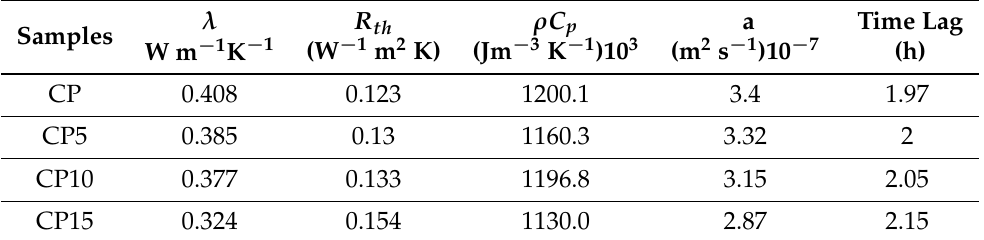
Table 2. Thermal properties of composites materials.